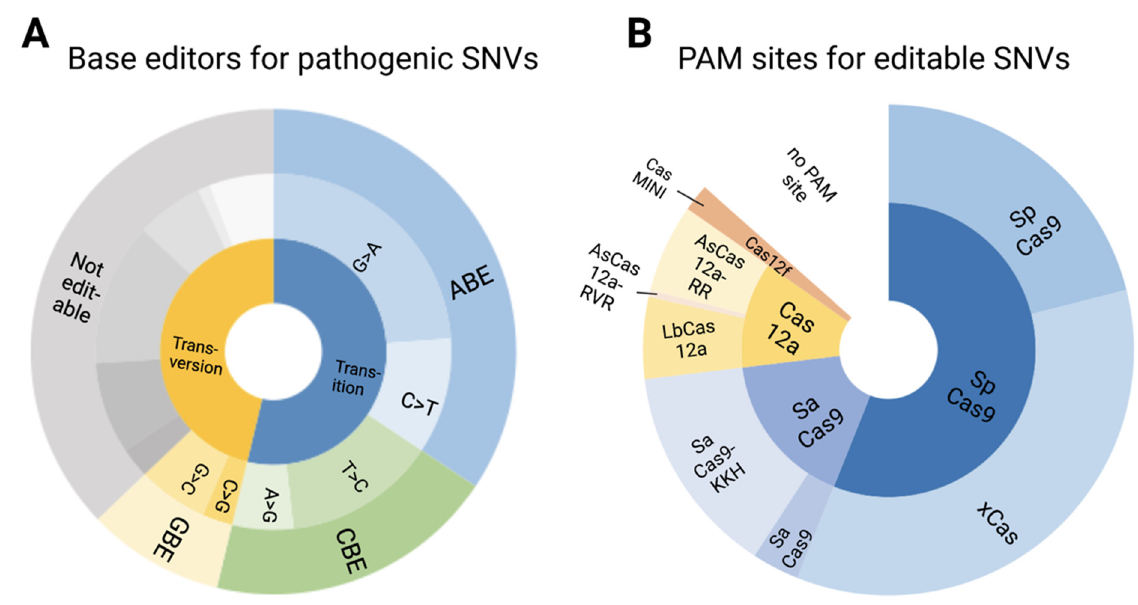
Figure 6. Amenability of pathogenic SNVs to base editing. ( A ) 53% of pathogenic SNVs were transitions and therefore amenable to base editing. 9% of editable SNVs were C:G to G:C transversions, editable with GBEs. In total, 62% of pathogenic SNVs were amenable to a base editor. The largest subset of editable SNVs (34%) contained G:C to A:T mutations and was thus amenable to treatment with an ABE. ( B ) Of the editable SNVs, 87% were found to have a PAM site in the appropriate editing window. The largest proportion were amenable to SpCas9, in particular the Cas9 variant xCas, which is due to the relaxed PAM site of 5 ′ -NG-3 ′ . The novel CasMINI bears great potential due to its small size but was not amenable to many SNVs due to the small editing window and specific PAM requirements.